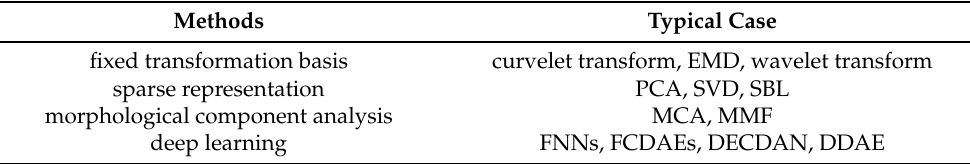
Table 1. Conventional noise attenuation